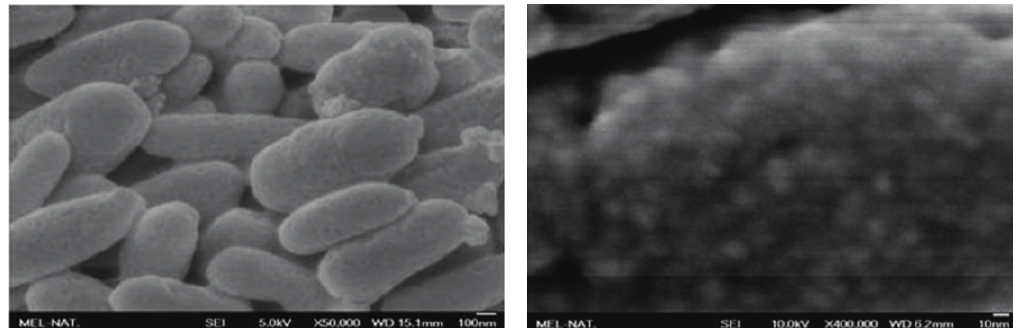
Figure 9: SEM images of the natural melanin used in the experiments.